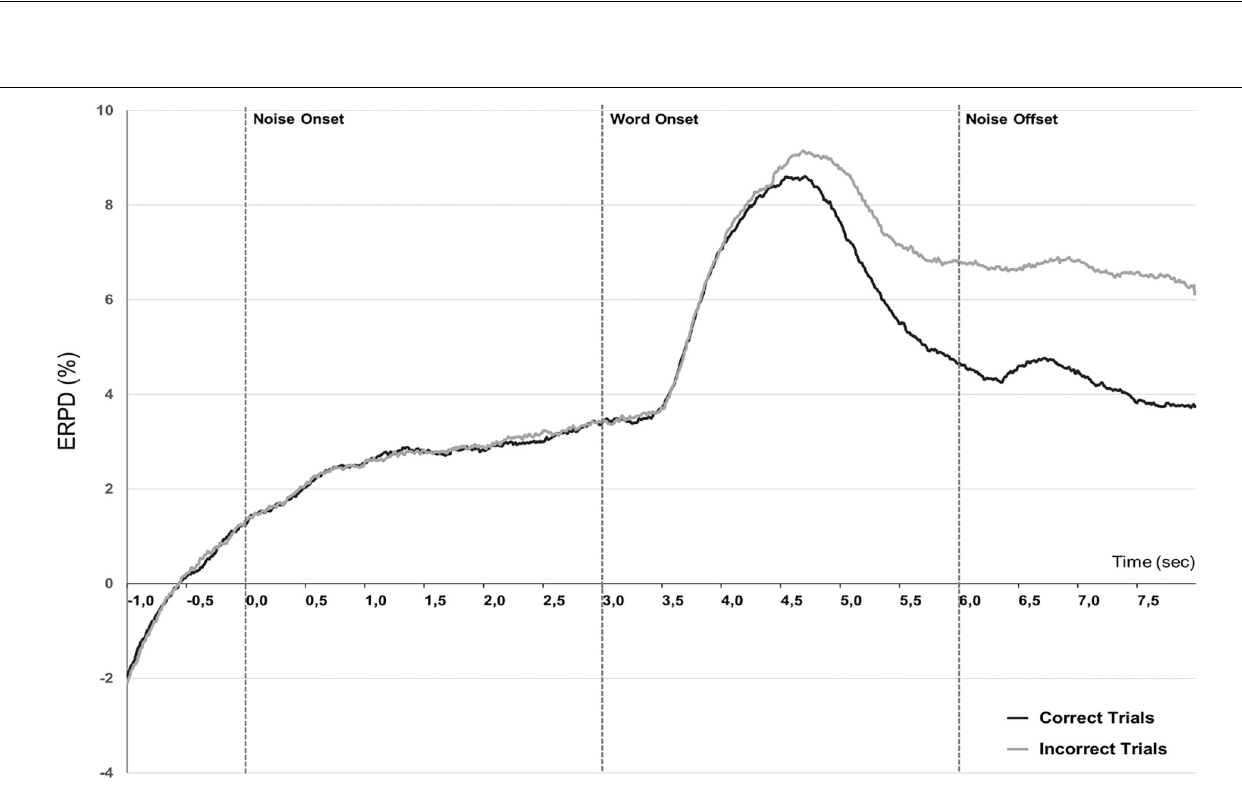
Frontiers in Neuroscience |